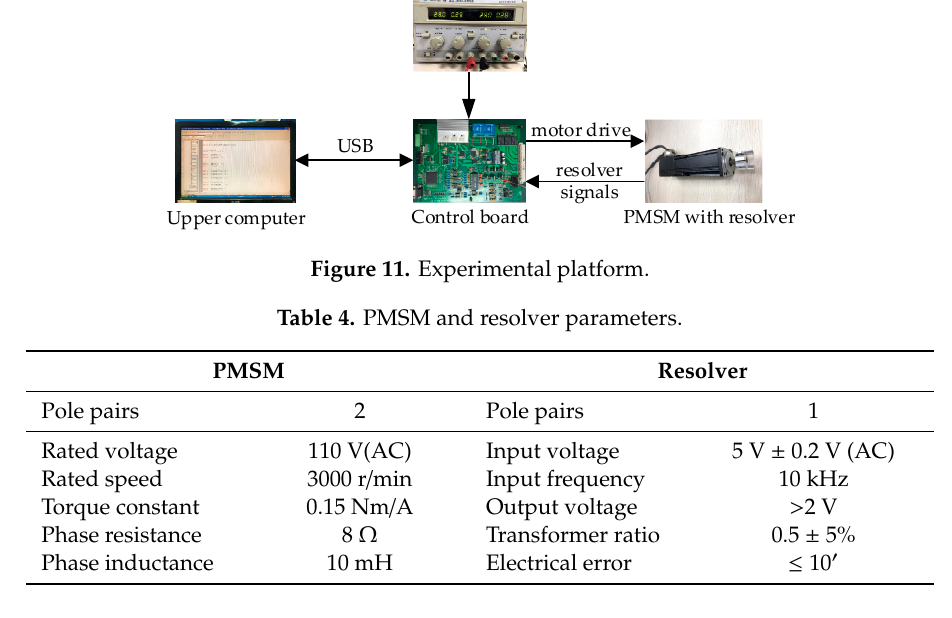
Table 5. Partial singular values of approximation coefficient